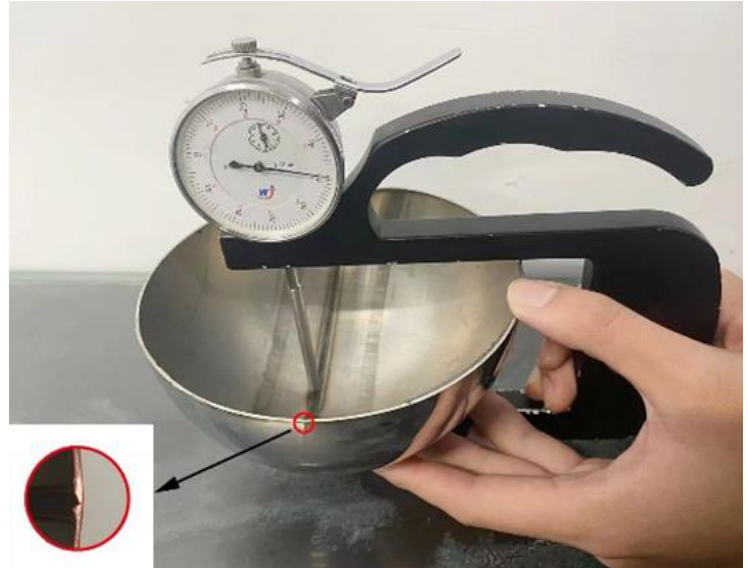
Figure 6. Welding thickness measurement.